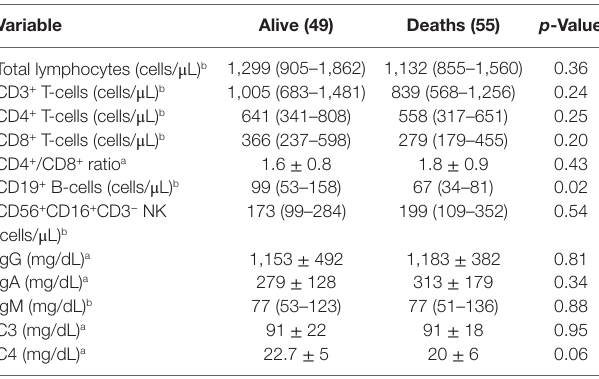
TaBle 3 | Lymphocyte populations, immunoglobulins, and complement results and mortality. Variable alive